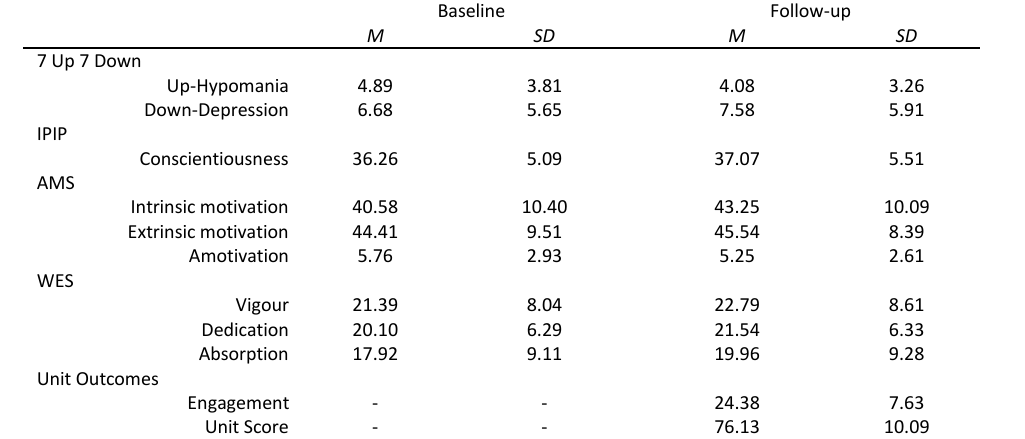
Means and Standard Deviations for Predictor and Outcome Variables in Both Baseline (n = 72) and Follow-up (n = 24) Samples Baseline Follow-up